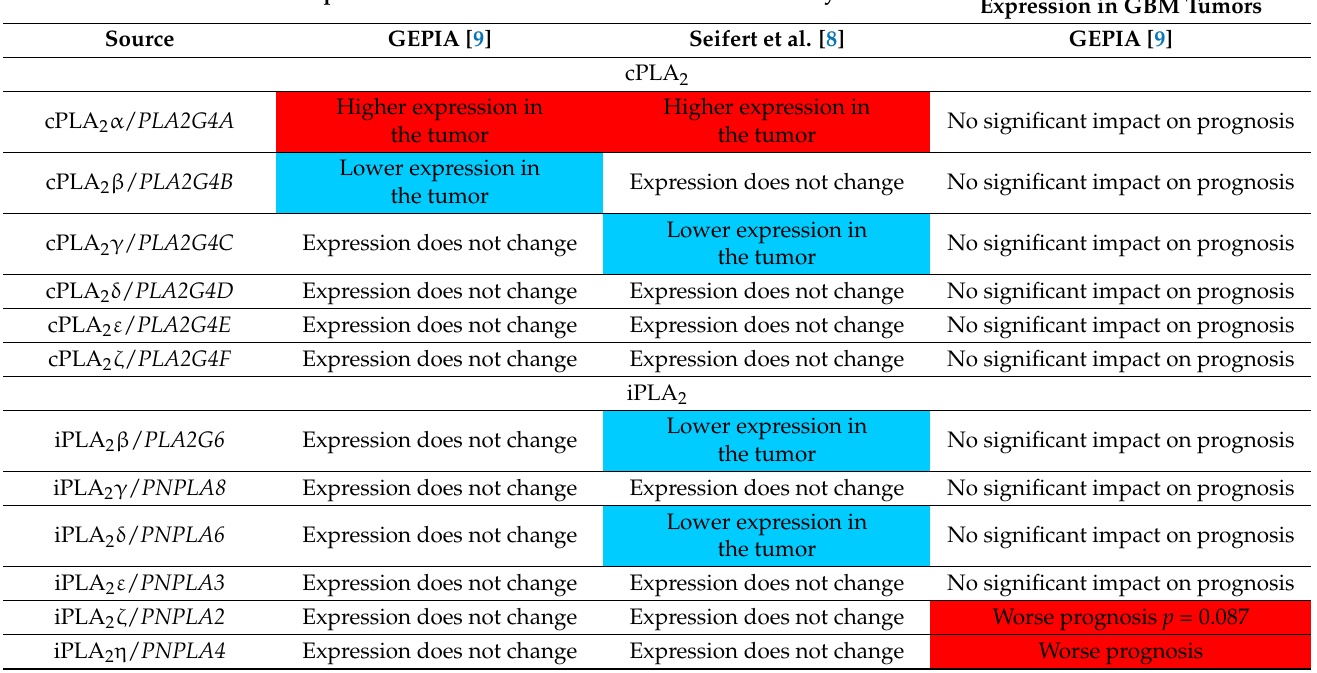
Table 1. Description of cPLA 2 and iPLA 2